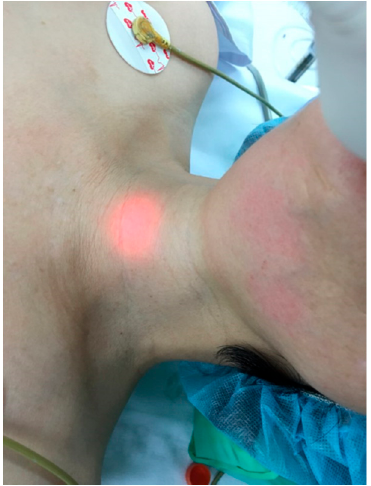
Figure 1. Transillumination of the suprasternal soft tissues by the lighted stylet.